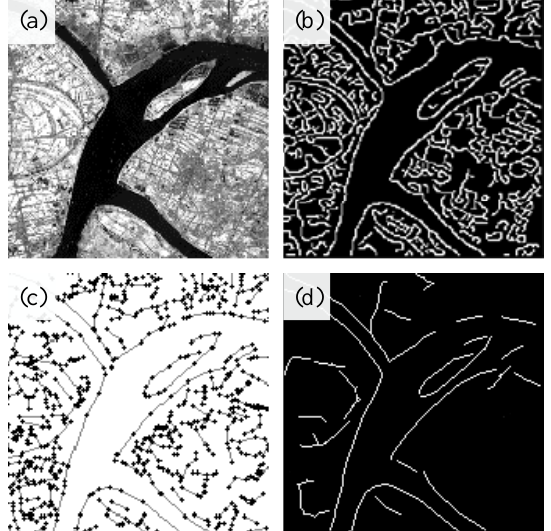
Figure 2. Comparison of different edge detection algorithms, (a) original image, (b) canny edge detection, (c) primal sketch, (d) main structure.